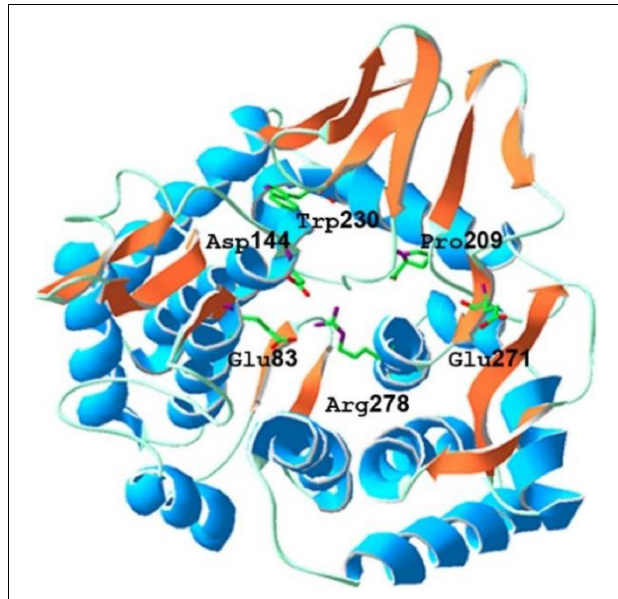
FIGURE 1 | The predicted tertiary structure of Burkholderia pyrrocinia JK-SH007 BpEG. The catalytic glutamic acid residues and other conserved residues of GH8 are indicated in the above